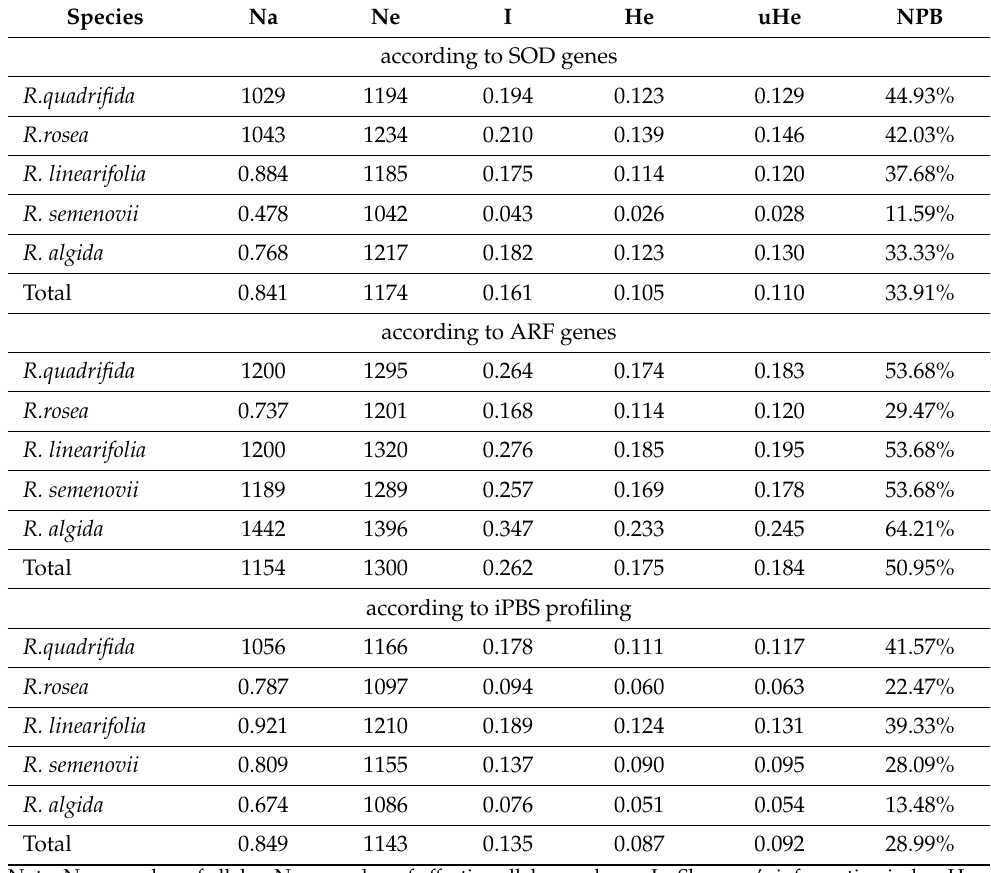
Table 1. Genetic diversity of Rhodiola species using genetic polymorphism data obtained by EPIC-PCR and iPBS profiling. Species Na Ne I He uHe NPB according to SOD